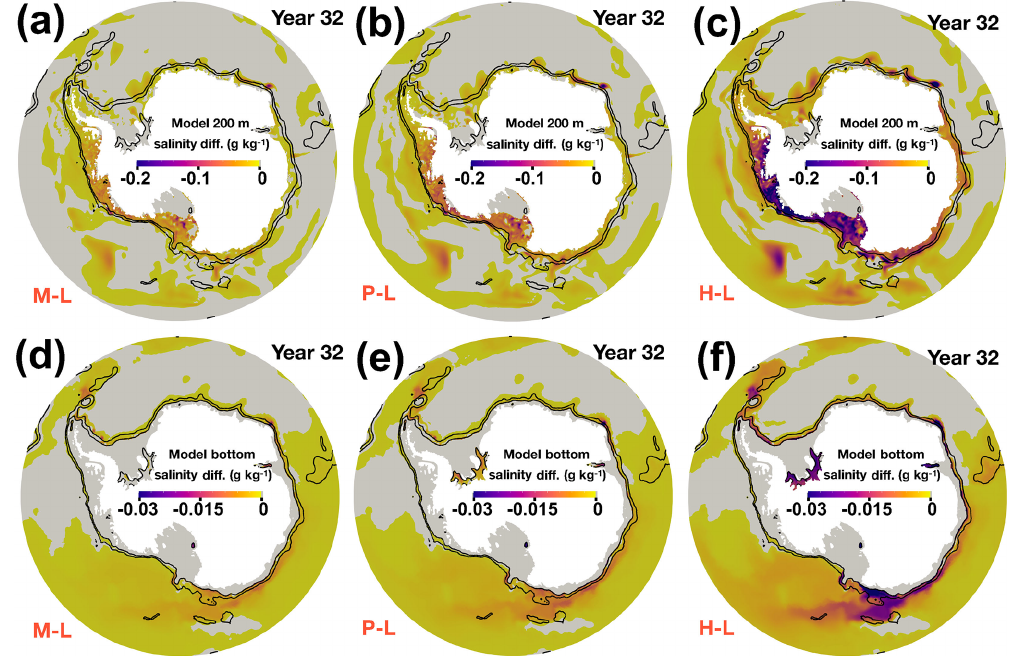
Figure 7. January mean absolute salinity differences MMELT − LMELT (M–L) for year 32 at (a) 200m depth and (d) bottom. The same for PRS − LMELT (P–L) and HMELT − LMELT (H–L) is shown in (b, e) and (c, f) , respectively. Bottom properties are only shown for regions deeper than 1500m. The bathymetry contours of 1000 and 2500m are shown with black lines. Positive values are indicated in